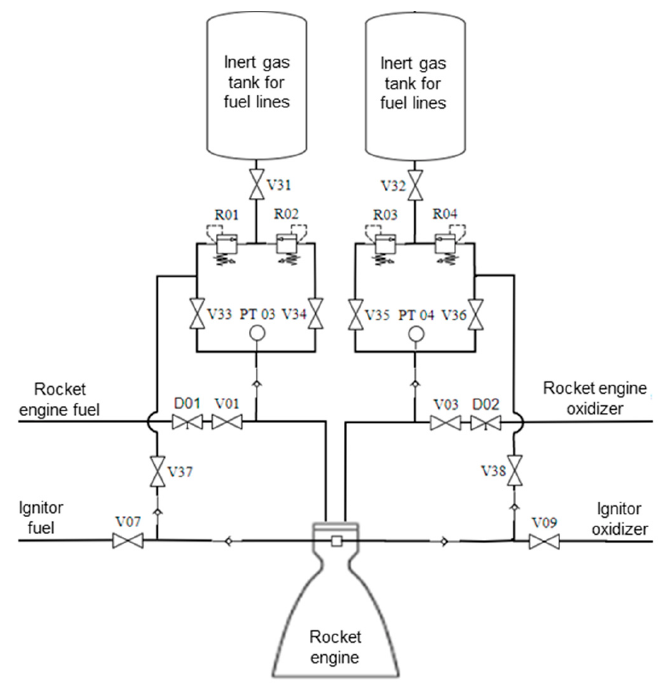
Figure 2. Purge-system component diagram.